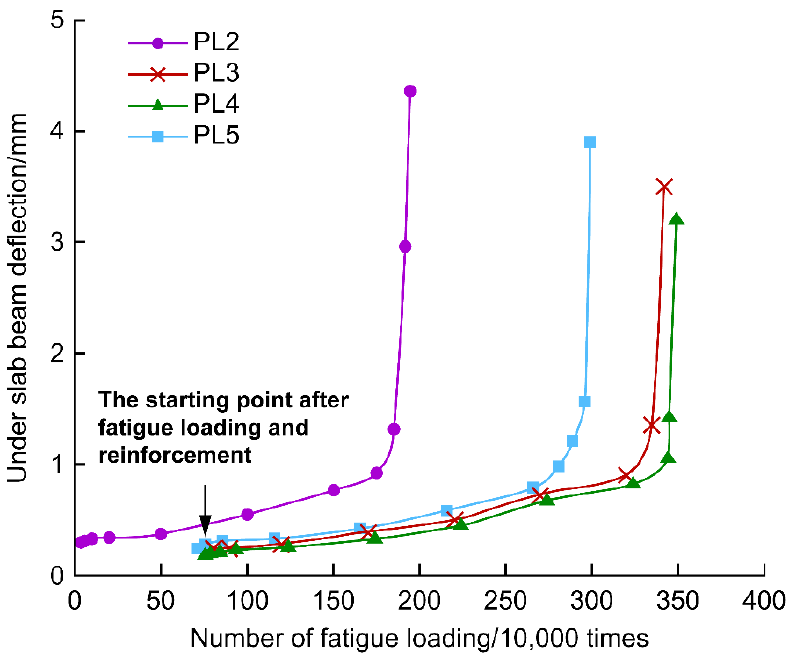
Figure 19. Relative deflection under the slab at loading point of test beam.